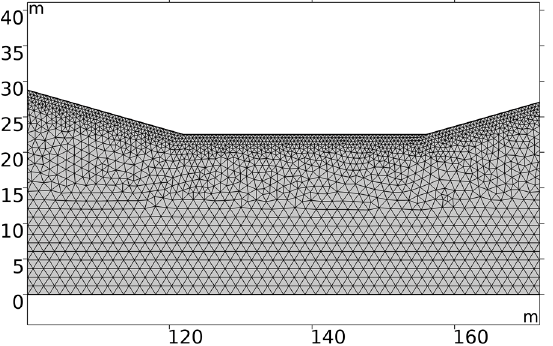
Figure 3. FEM mesh used in the computation for seabed in the vicinity of the foundation trench.